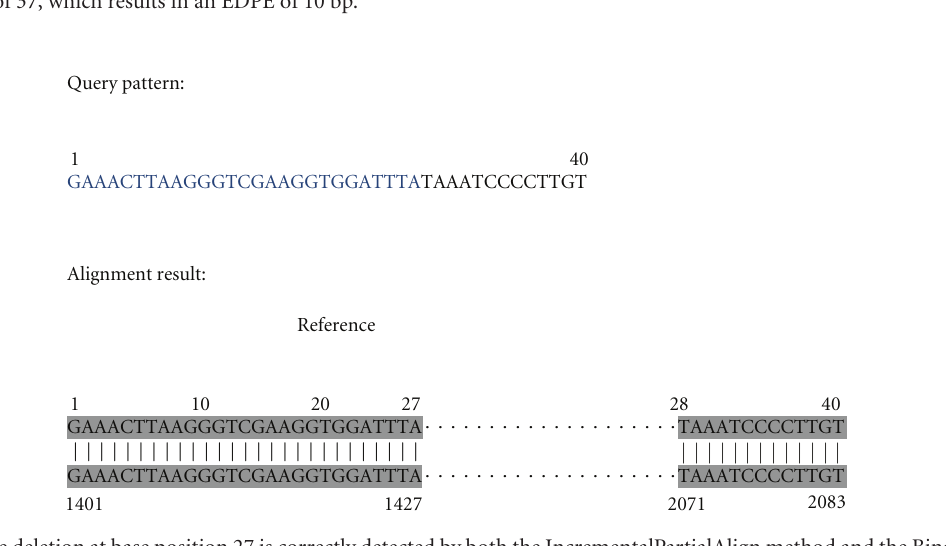
Figure 2: Failure of the classical Smith-Waterman alignment in detecting the large deletion at base position 27. In this simulated experiment, the former part is actually known to be the first 27 nucleotides printed in blue in the “Query pattern”. In “Alignment result”, bases shown in red do actually belong to the latter part but were aligned together with the nucleotides of the former part of the query. SW gives the deletion position estimate of 37, which results in an EDPE of 10 bp.